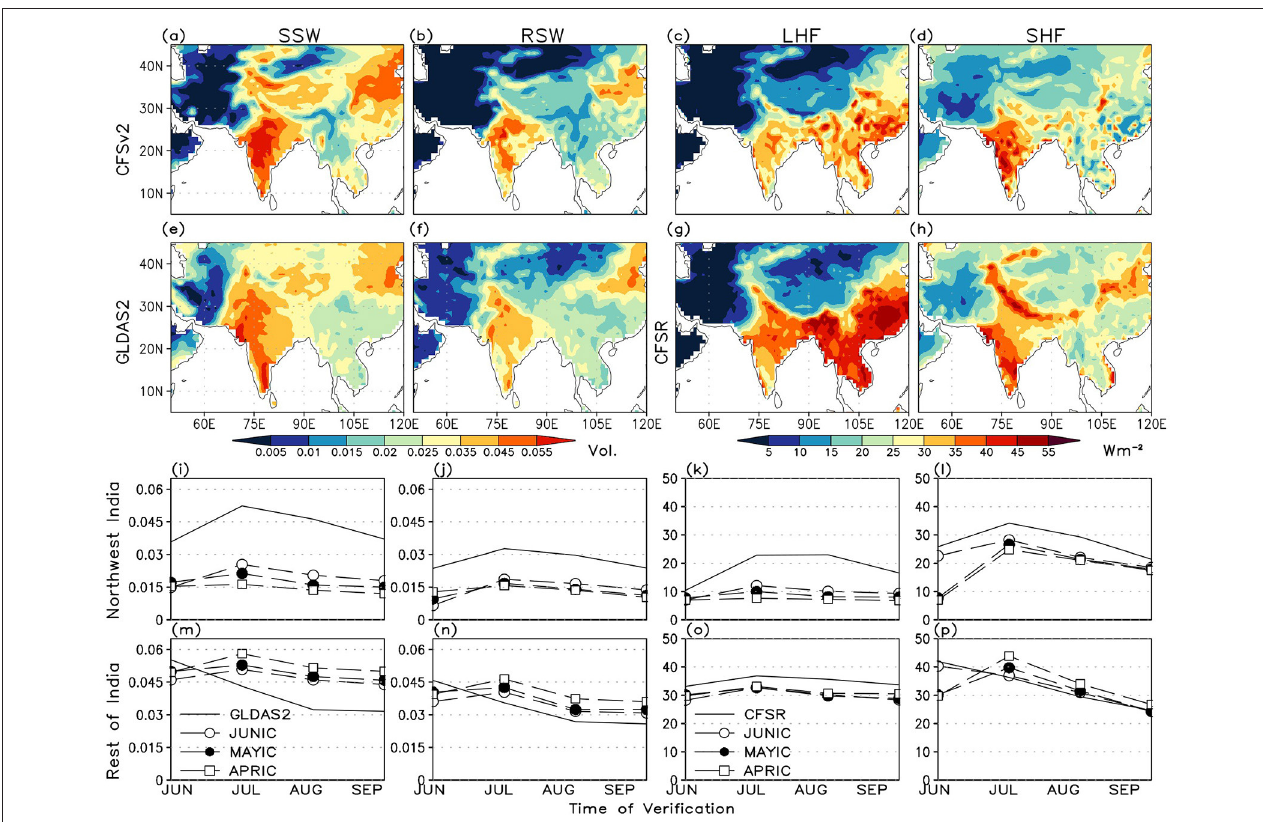
FIGURE 5 | Ensemble-mean daily variability of (a) SSW, (b) RSW, (c) LHF, and (d) SHF in JJAS for CFSv2 JUNIC hindcasts. Observed variability of (e) SSW and (f) RSW are based on GLDAS2 whereas that of (g) LHF and (h) SHF are based on CFSR. Units of variability for soil wetness are Volumetric and Wm − 2 for fluxes. (i–p) show the daily variability in different months for the northwest and rest of India domains, respectively; from JUNIC, MAYIC, and APRIC hindcasts and for GLDAS2 and